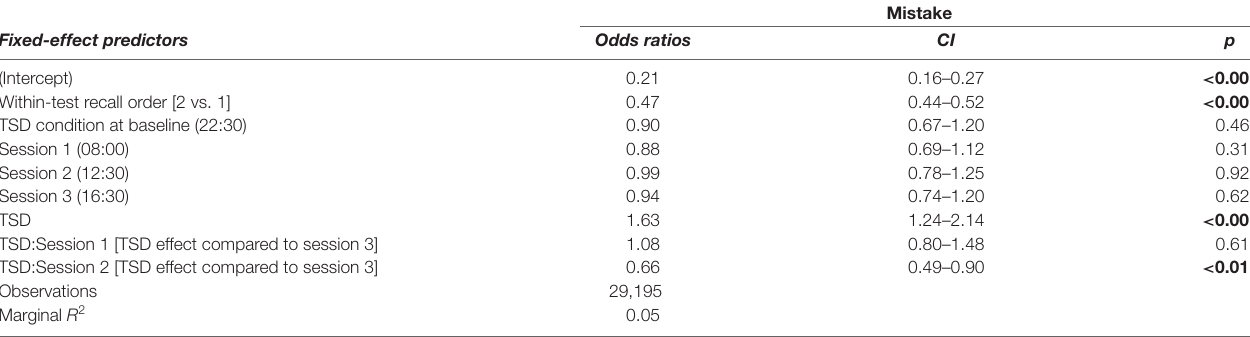
TABLE 3 | Episodic memory test performance (odds ratio for making a mistake) predictions based on sleep condition and time-of-day effects in the final mixed-effects model.